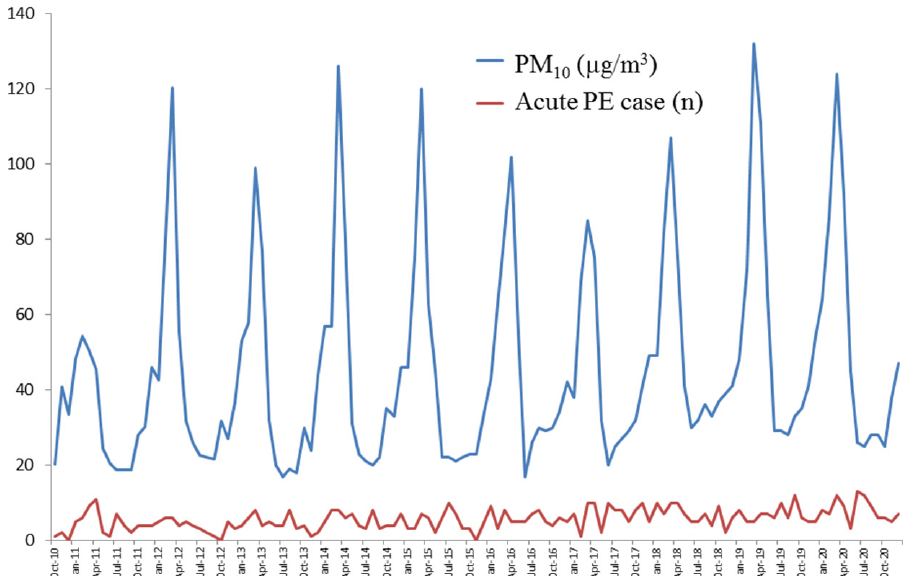
Figure 1. Variation in monthly average PM 10 and monthly acute PE cases throughout the study period (October 2010–December 2020).